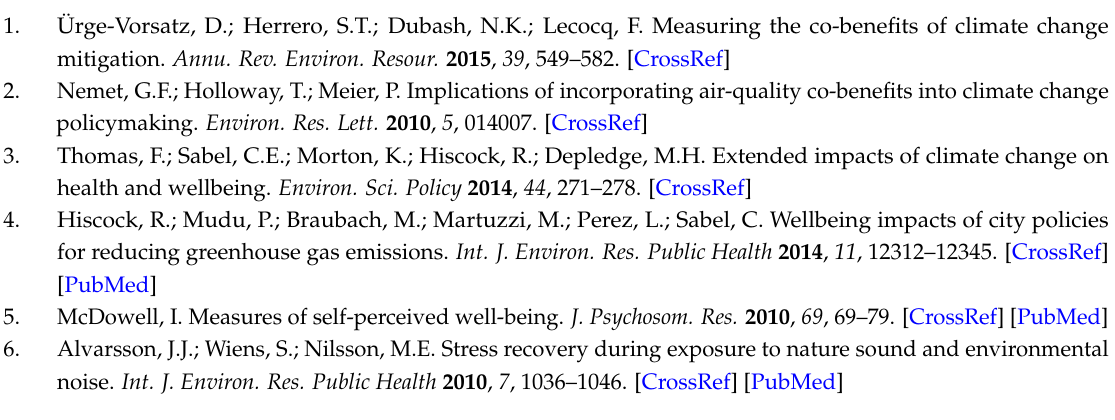
Table S6: Transport model, Table S7: Below are some statements about environment. How strongly do you agree or disagree with each one, Table S8: Health variables, Table S9: Design